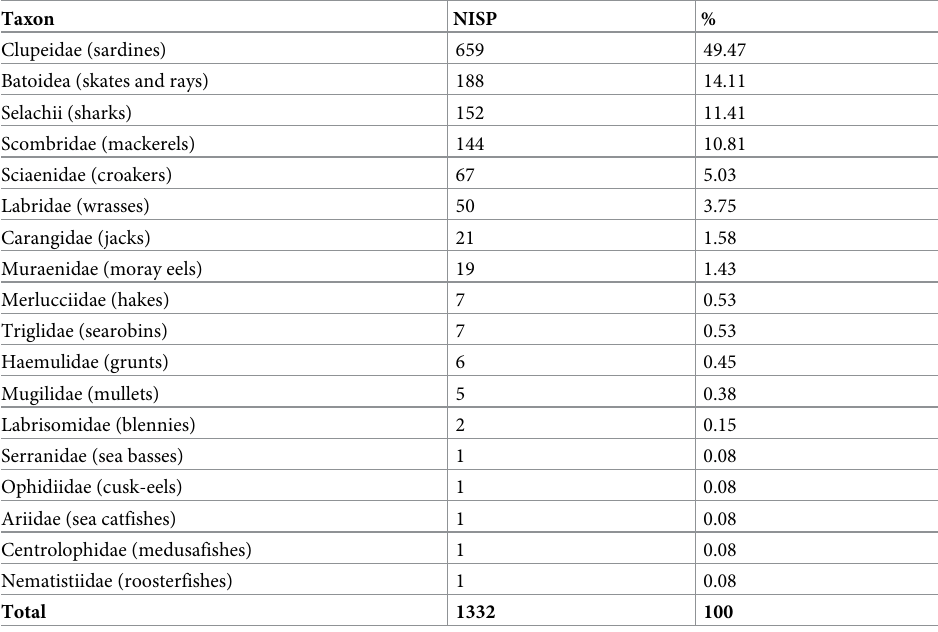
Table 4. Huaca Grande fish assemblage. NISP and proportions of the taxa identified in trench A4.1.